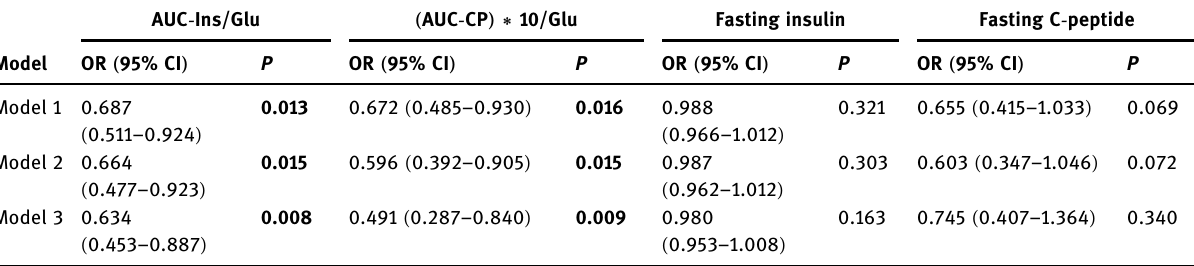
Table 2: Binary logistic regression analysis of the relationship between β - cell function and osteosarcopenia AUC - Ins/Glu Fasting insulin Fasting C -